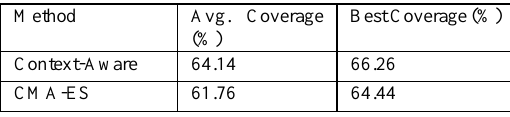
Figure 3: Part of the campus of Université Laval